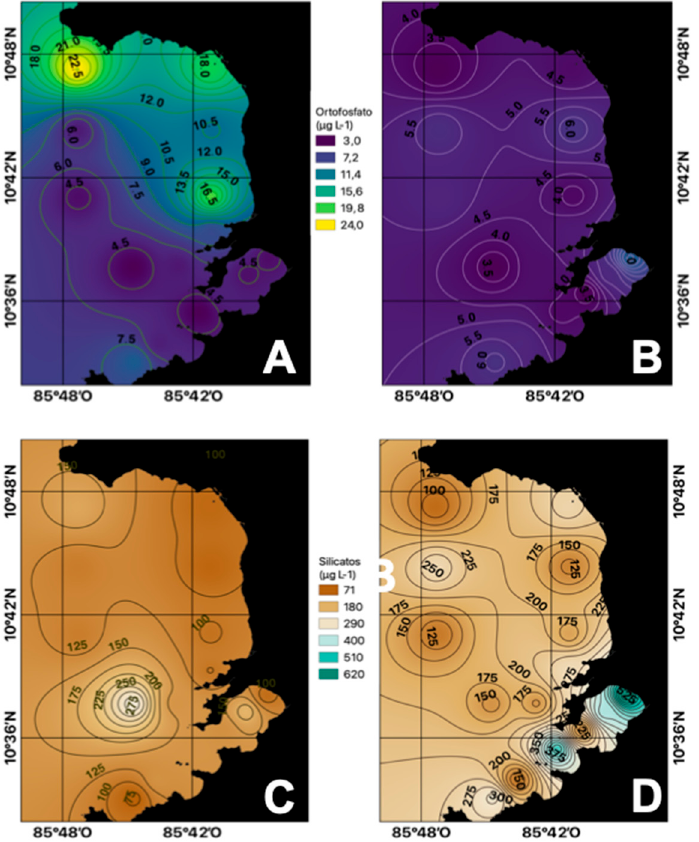
Figure 4. Spatial distribution of the average concentrations of phosphate (( A ) dry season, ( B ) rainy season) and silicate (( C ) dry season, ( D ) rainy season) in the Gulf of Papagayo.